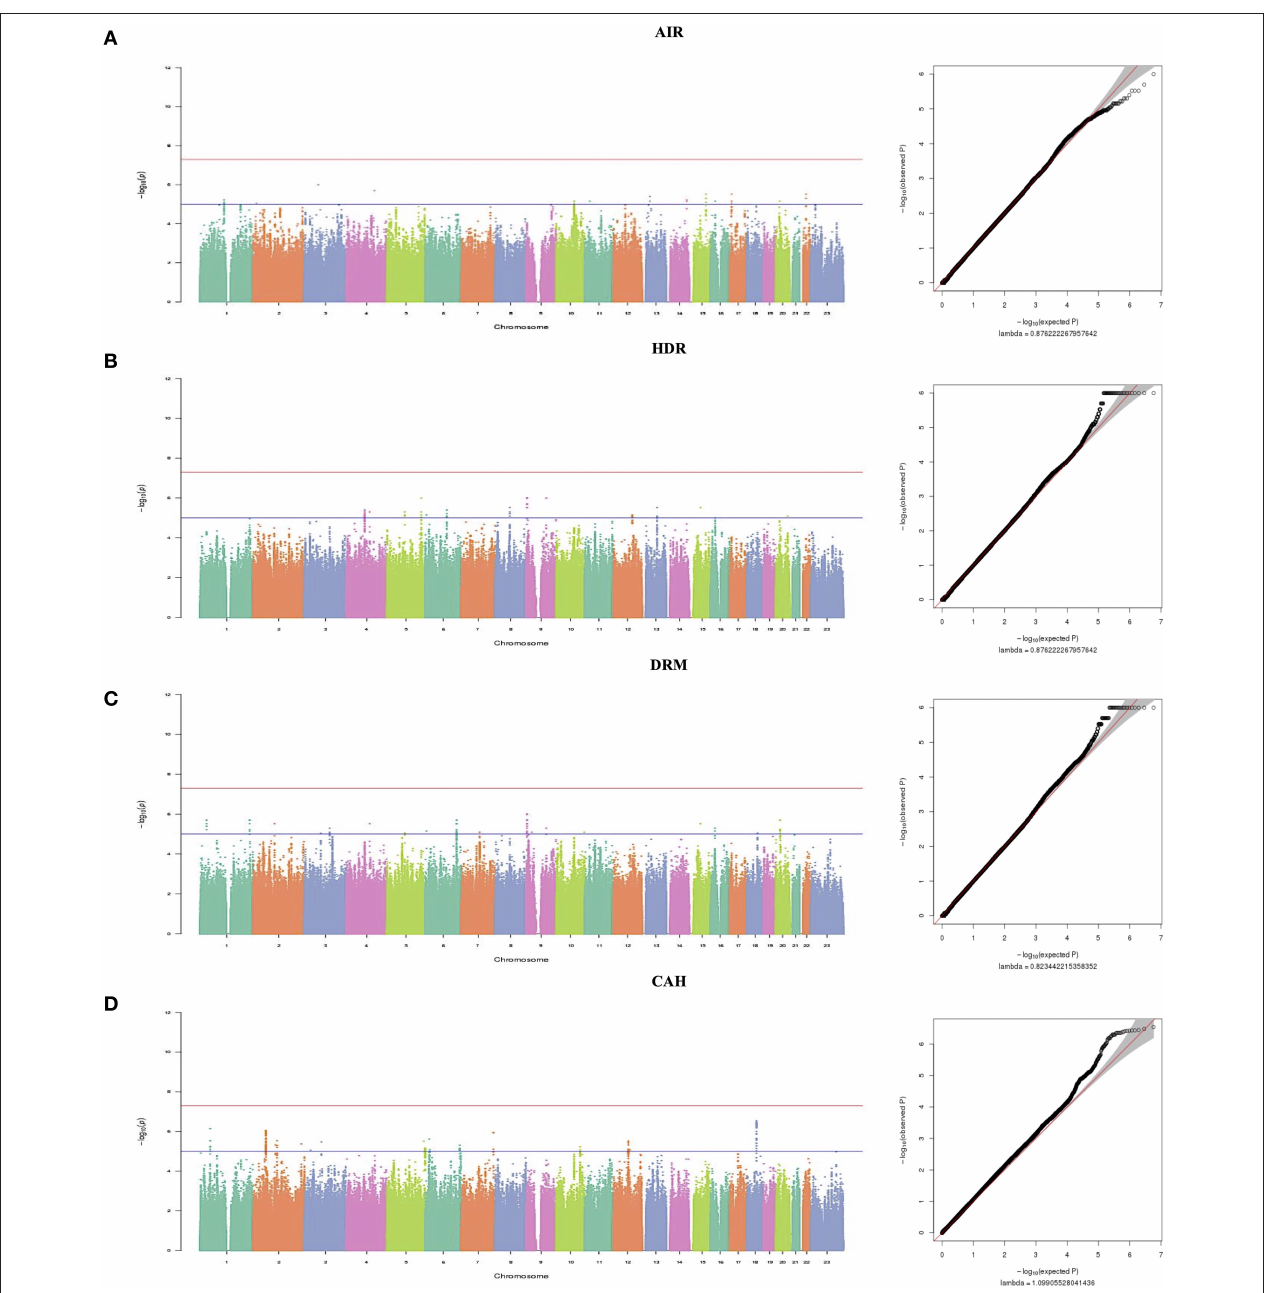
FIGURE 1 | Manhattan plots and (Q-Q) plots showing multivariate GWAS results for the correlated dental anomalies patterns and dental caries. In the Manhattan plot the red lines represent thresholds for genome-wide significance ( p < 5 × 10 − 8 ). Blue lines represent thresholds for suggestive significance ( p < 5 × 10 − 6 ) and it shows negative log10-transformed p -values (y-axis) across the whole genome (x-axis). Genotyped and imputed SNPs are plotted together. (A) On the left is the Manhattan plot for Tooth Agenesis, impaction and Rotation (AIR), on the right is the quantile–quantile plot (Q-Q), and the genomic inflation factor ( λ ) is 0.87. (B) On the left is the Manhattan plot for Hypoplasia, displacement and rotation (HDR), on the right is the quantile–quantile plot (Q-Q), and the genomic inflation factor ( λ ) is 0.87. (C) On the left is the Manhattan plot for Displacement, Rotation and Mamelon (DRM), on the right is the quantile–quantile plot (Q-Q), and the genomic inflation factor ( λ ) is 0.82. (D) On the left is the Manhattan plot for Dental caries, Agenesis and Hypoplasia (CAH), on the right is the quantile–quantile plot (Q-Q), and the genomic inflation factor ( λ ) is